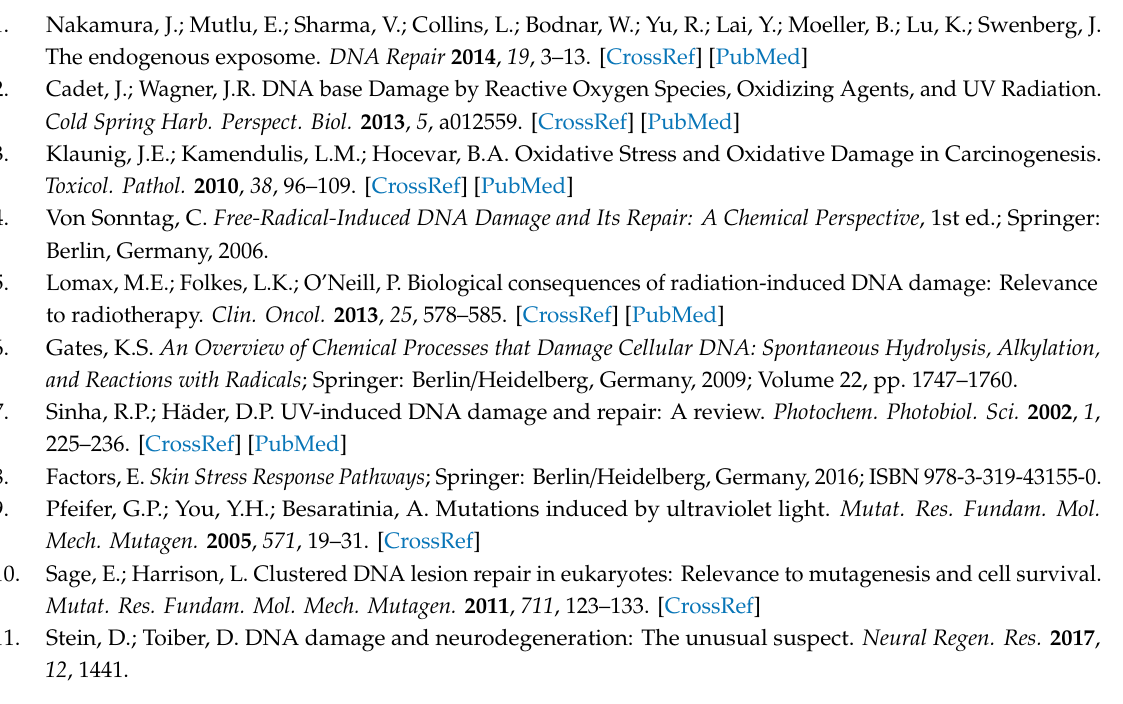
and Figure S3: Time evolution of the distances between K + and the guanine for all the damaged